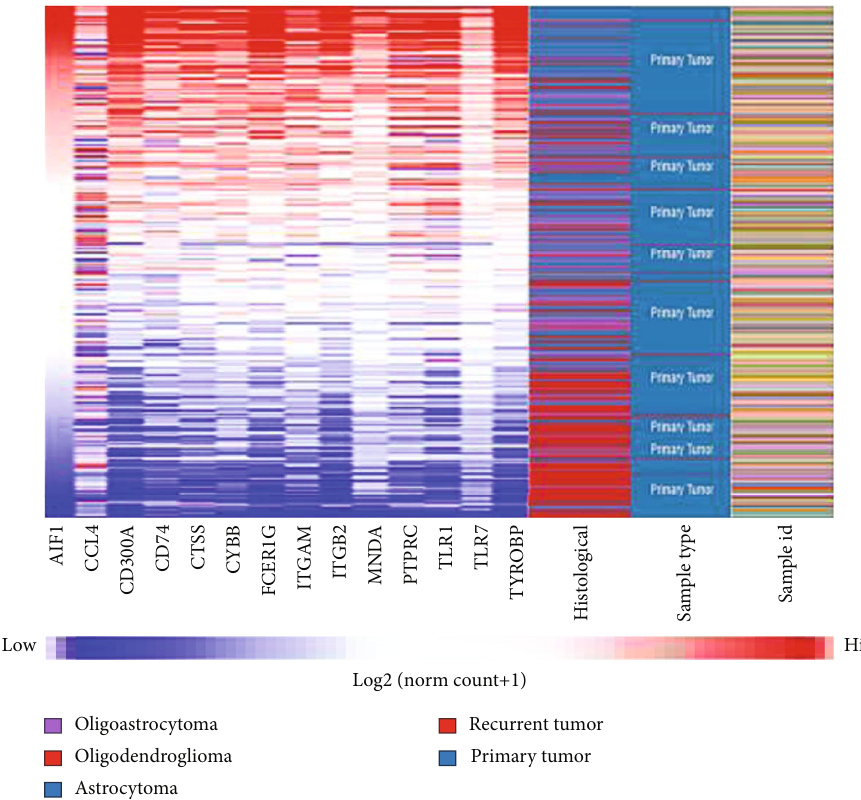
Figure 6: HC of 14 key DEGs was constructed using UCSC online web tools. The upregulated gene is labeled with red lines and the downregulated gene is labeled with blue lines. In the histological type, the purple stripe represents oligoastrocytoma, the red stripe represents oligodendroglioma, and the blue stripe represents astrocytoma. In the sample type, the blue stripe represents the primary tumor, and the red stripe represents the recurrent tumor. Table 3: KEGG pathway analysis of 14 key DEGs in LGGs by DAVID.